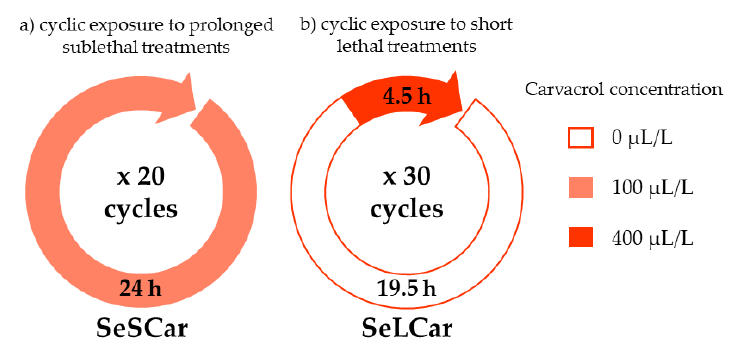
Figure 1. Schematic for the experimental protocols of carvacrol evolution assays: ( a ) cyclic exposure to prolonged sublethal treatments (SeSCar) and ( b ) cyclic exposure to short lethal treatments